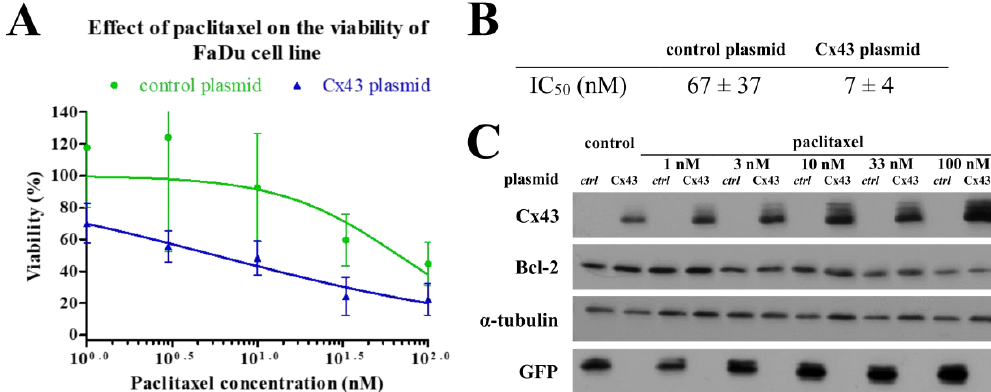
Figure 6. Changes in the effect of paclitaxel on cell viability of FaDu after transfection Cx43. FaDu cells were analyzed by trypan blue exclusion test after 48 h of treatment with paclitaxel at different concentrations. ( A ) IC 50 curves of paclitaxel on FaDu cell line. The results represent the mean of three independent experiments with SD. ( B ) IC 50 concentrations of paclitaxel measured in FaDu cell line.